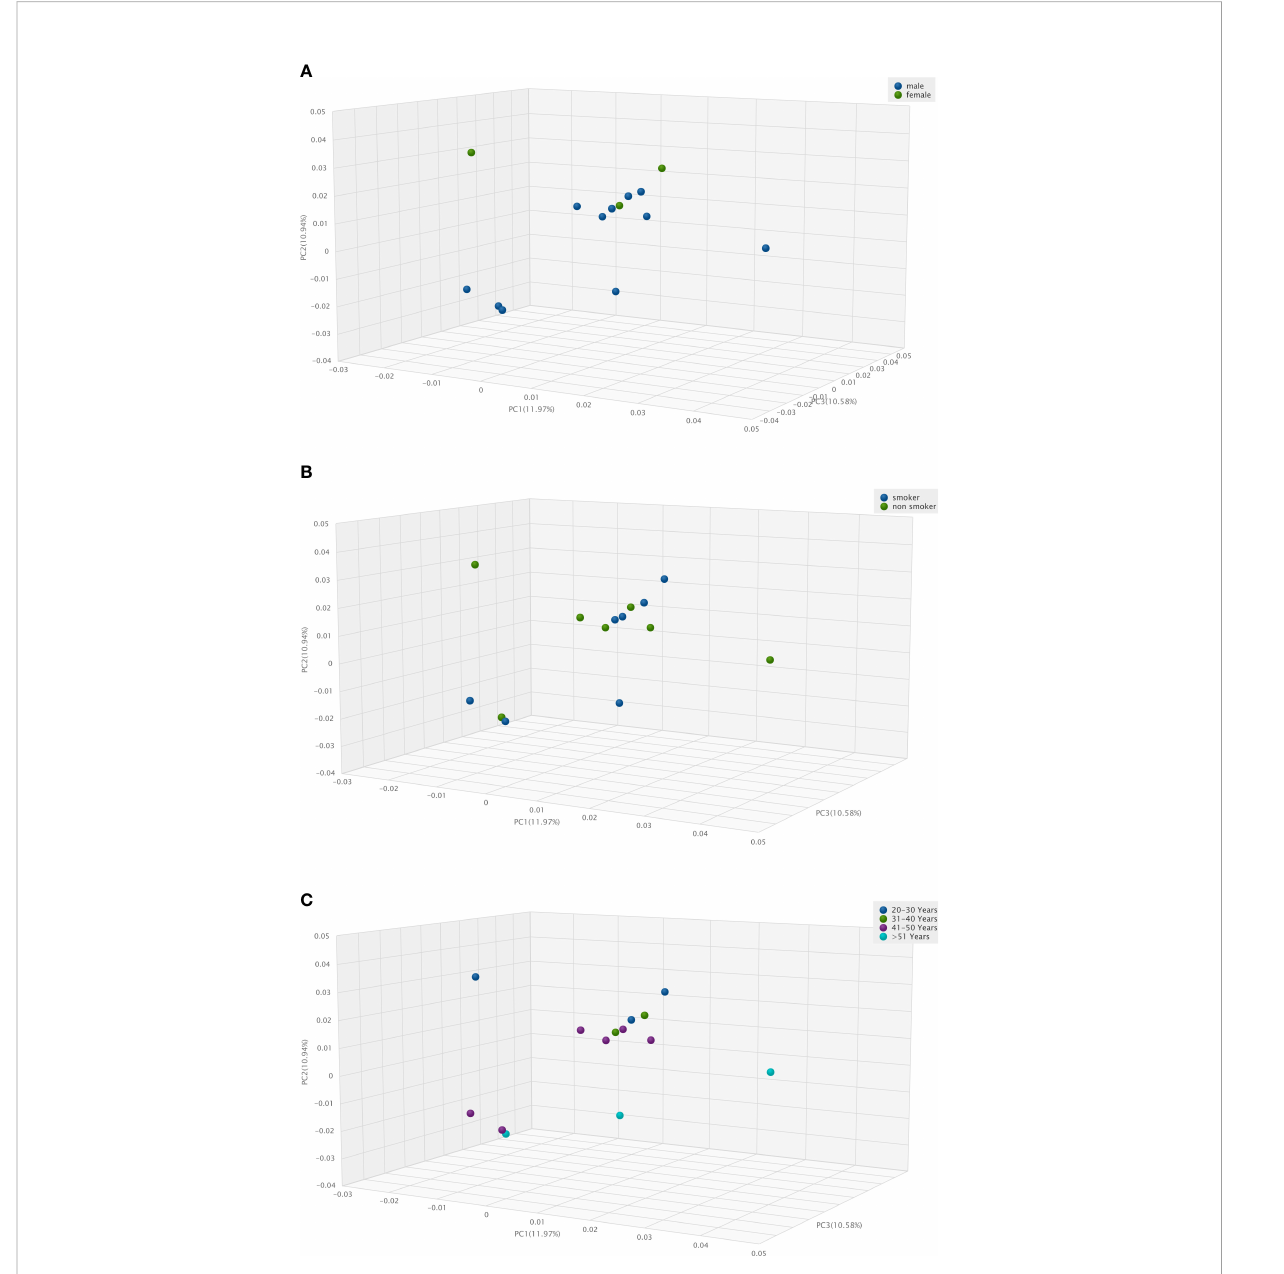
FIGURE 3 Three-Dimension Principal Component Analysis (3D PCA) of human vascular microbiome. (A) , in male and female patients, (B) , in smoker and non-smoker patients, (C) , according to age